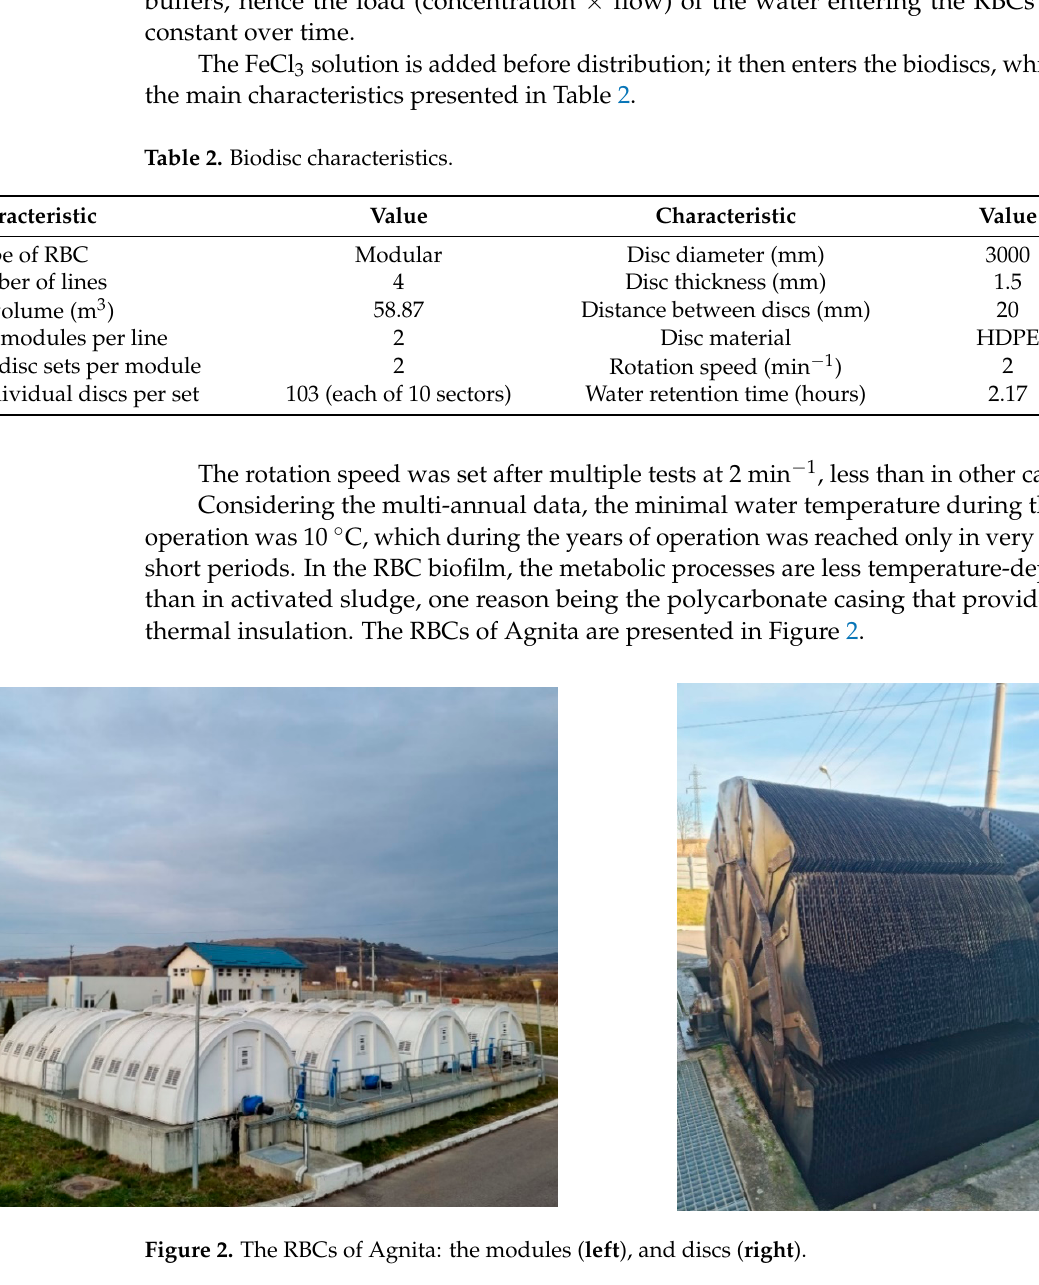
Table 3. Parameters and their analytical methods used in the Agnita